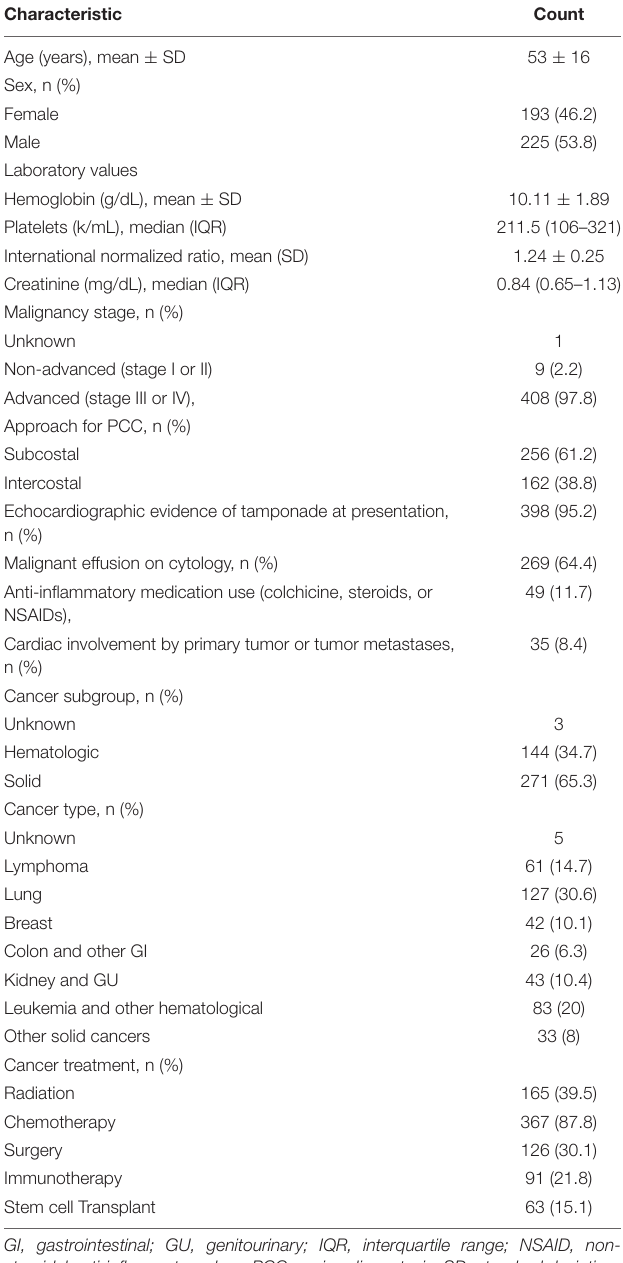
TABLE 1 | Baseline characteristics of the patients ( N =